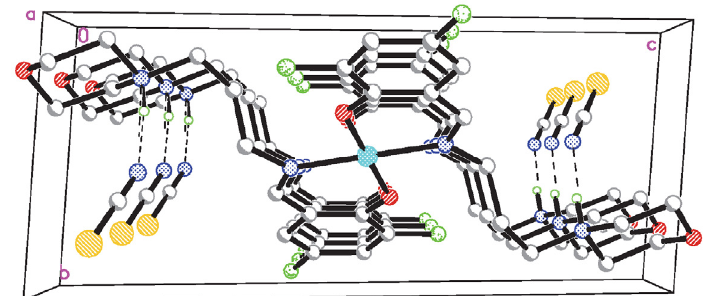
Figure 6. Molecular packing structure of complex 3 , viewed along the a axis. Hydrogen bonds are shown as dashed lines.